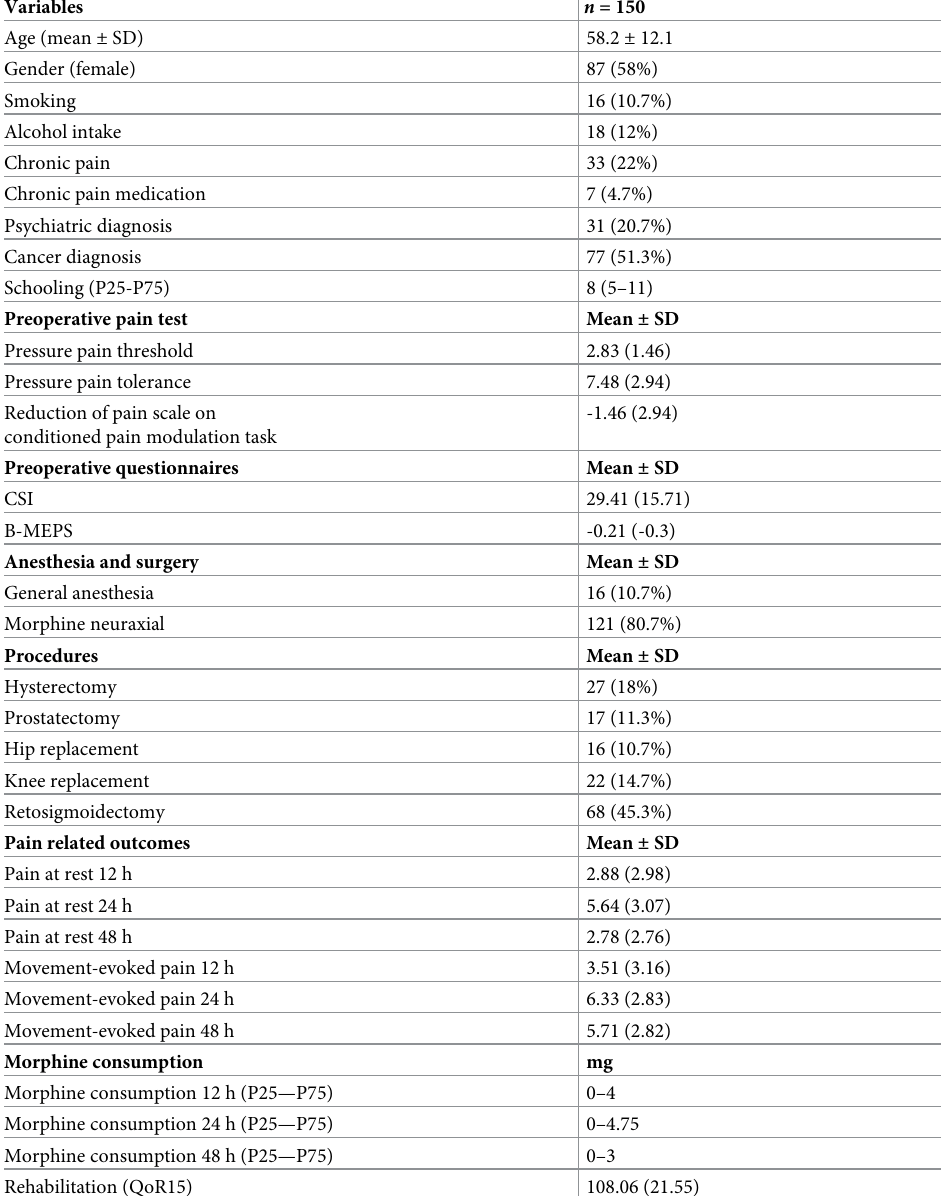
Table 2. Demographic and clinical characteristics, preoperative predictors and postoperative outcomes (n = 150).